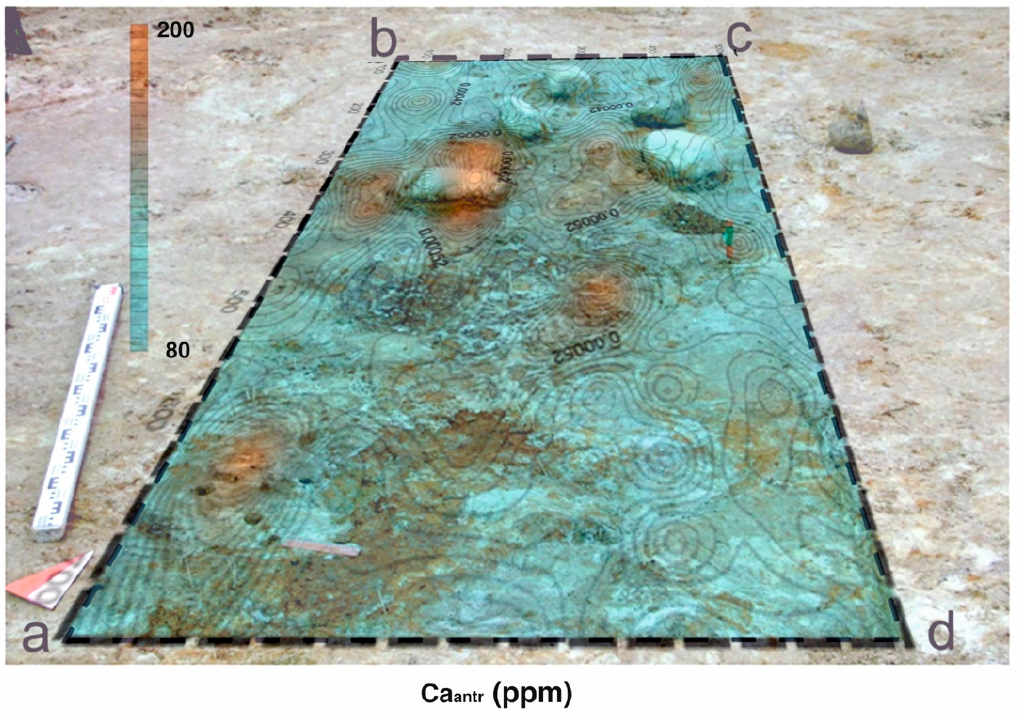
Figure 5. Distribution of Ca antr (ppm) on the surface of the burial layer at the Okhta 1 site [38], designed by M.Kulkova.